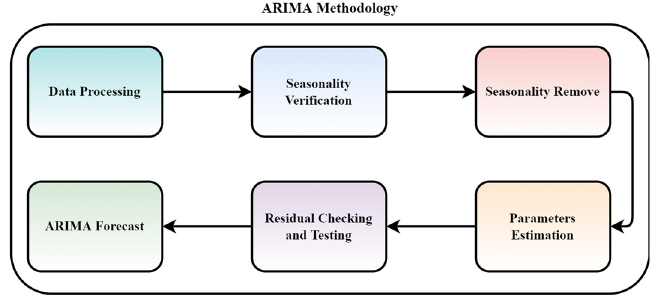
Figure 9. ARIMA methodology for the experimental framework.